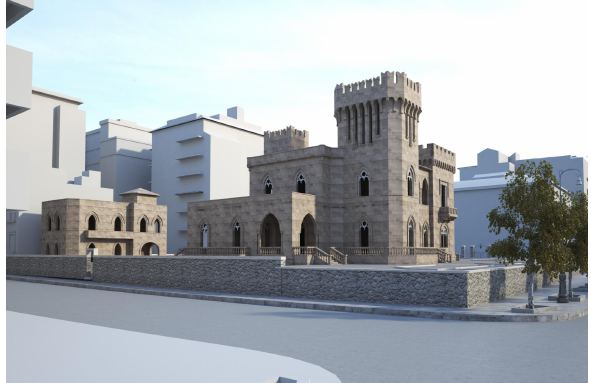
Figure 11 . 3d model contextualized in the current model.